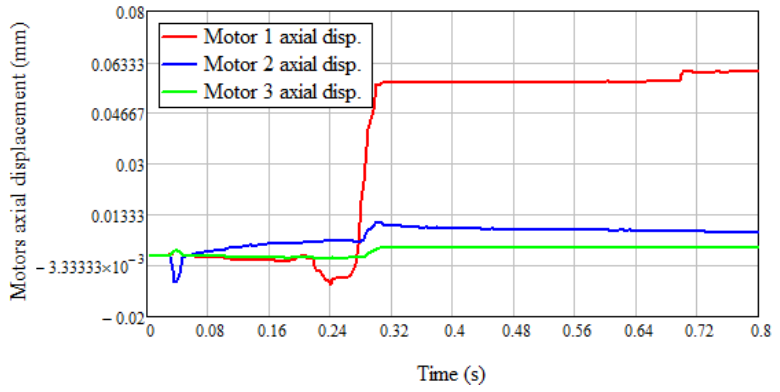
Figure 23. Time variations of axial deformations for the mass of 5 kg. The variation in the displace- ments for a time less than 0.28 s was due to the manual actuation.